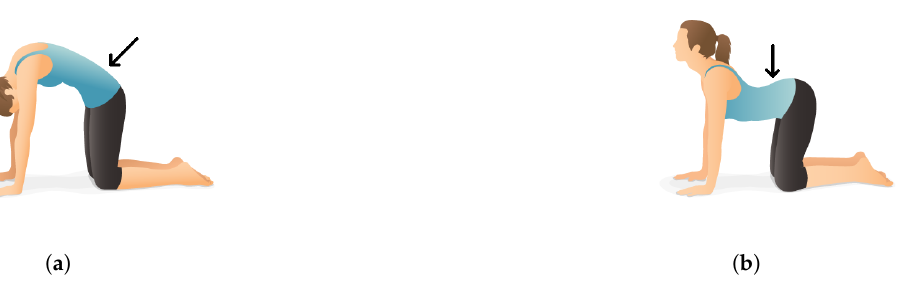
Figure 12. Illustration of the first exercise: periodic concavity of the spine (Images provided by Pocket Yoga (www.pocketyoga.com)). The arrows indicate the position of the sensor node. ( a ) Start position. ( b ) End position.